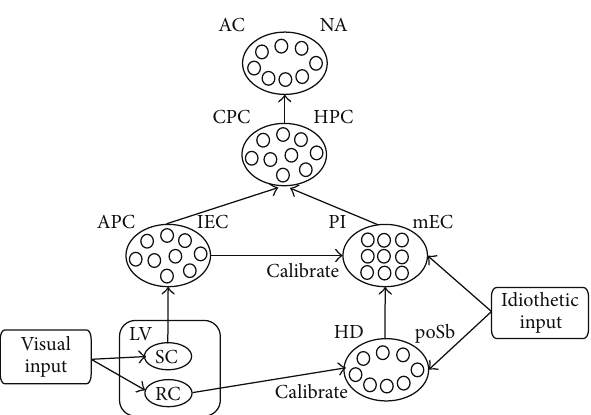
Figure 4: Simulated neural system. Redrawn with permission from Str¨osslin et al.